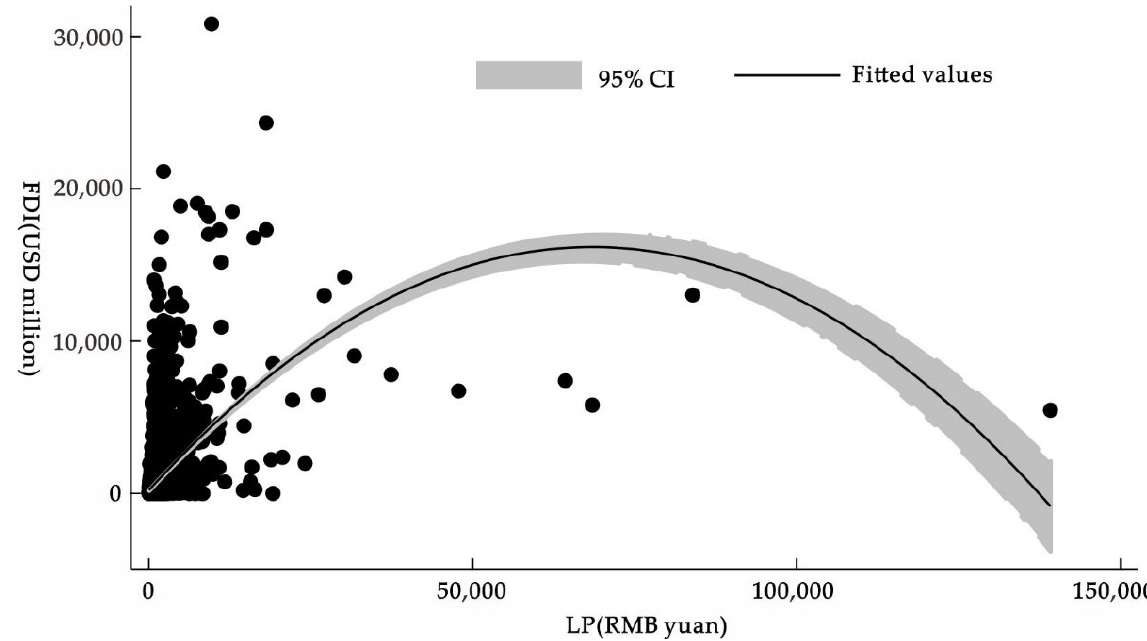
Figure 7. Scatterplot of the relationship between FDI and land prices from 2003 to 2019. 7. Heterogeneity in the Effects of Land Marketization Level and Land Prices on